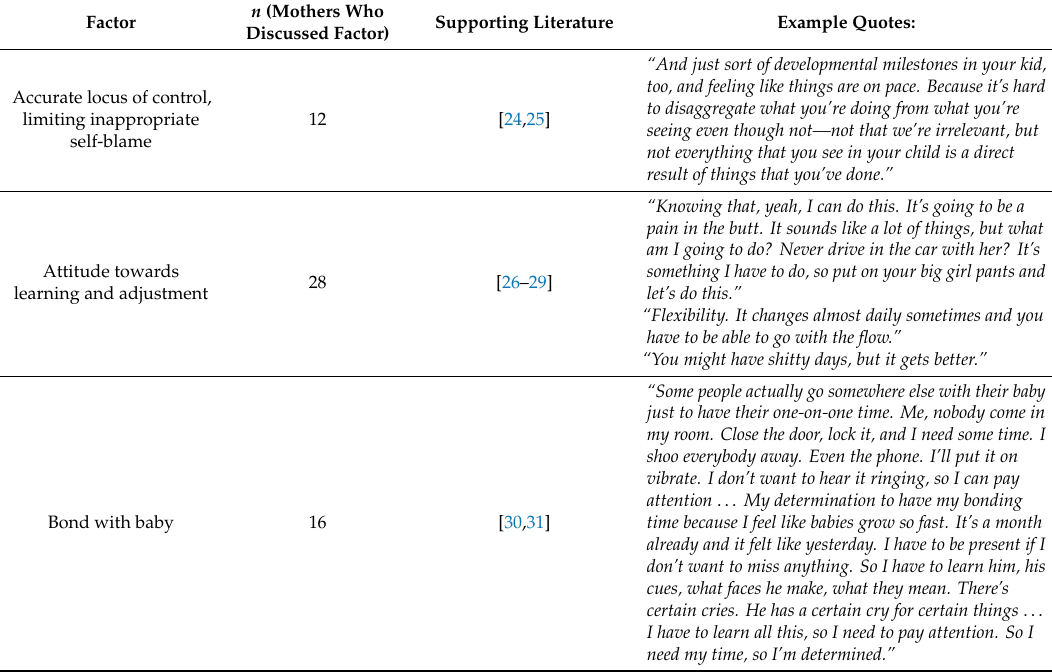
Table 2. Factors influencing maternal functioning revealed through qualitative